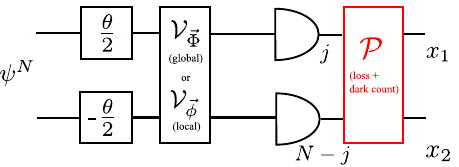
Fig. 8 | Sensing the relative phase θ with a pure N -photon state, ψ N , in a lossy interferometer with dark counts. Either a global(affects all the photons) or local (affects each photon separately) control unitary is allowed. The imperfect mea- surement is described by an ideal photon-number detection ( j , N − j ) at the output modes, followed by a noisy detection channel P that incorporates losses and dark counts, resulting in ( x 1 , x 2 ) registered detection